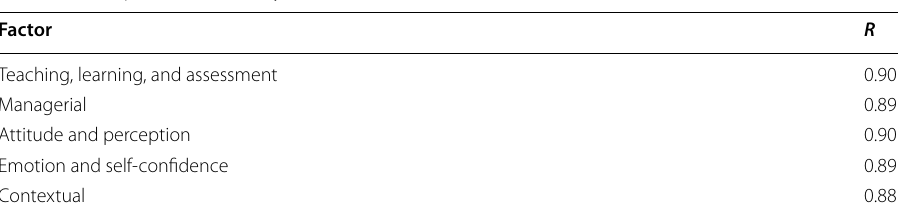
Table 2 Components reliability indices